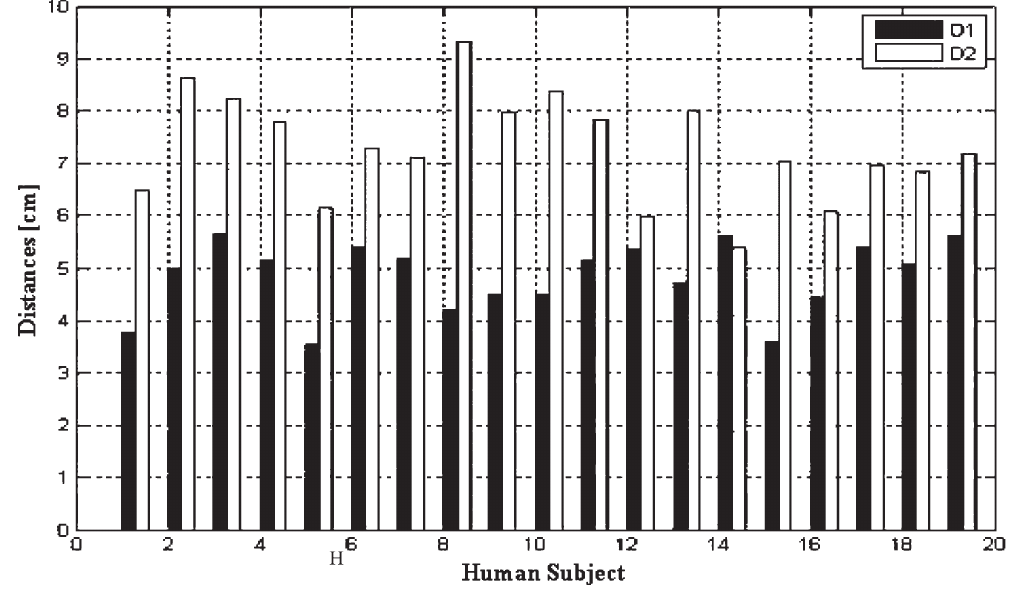
Fig. 9. Foot distances D 1 (black bars), and D 2 (white bars), measured for 19 human